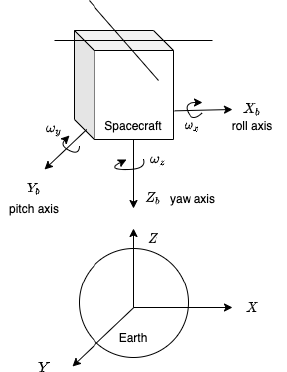
Figure 2. The body frame of